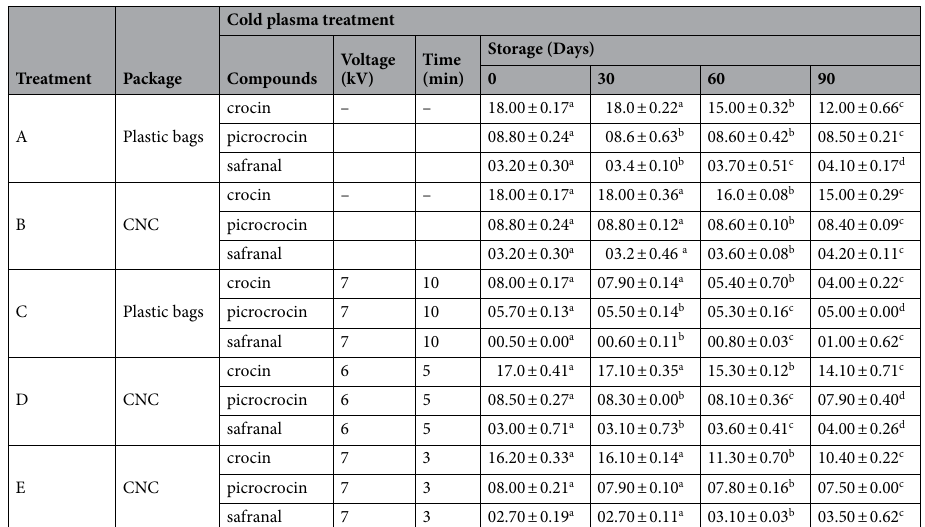
Table 2. The effect of the cold plasma treatment and the packaging on safranal, crocin and picrocrocin (%) of saffron. A: The Saffron is packed in a plastic bag without any treatment and stored for 30, 60, and 90 days. B: The Saffron is packed by PNC package without any treatment and stored for 30, 60, and 90 days. C: The Saffron is treated by cold plasma for 10 min at 7 kV (the time and voltage needed for complete decontamination) and then packed in a plastic bag without any treatment and stored for 30, 60, and 90 days. D: The CNC packed Saffron is treated by cold plasma for 5 min at 6 kV and stored for 30, 60, and 90 days. E: The CNC packed Saffron is treated by cold plasma for 3 min at 7 kV and stored for 30, 60, and 90 days. Safranal, crocin, and picrocrocin (%) were enumerated during treatment. abcd means in the same row followed by different superscript letters are significantly different ( P < 0.05). Data represent the mean ± standard deviation of each sample (n =